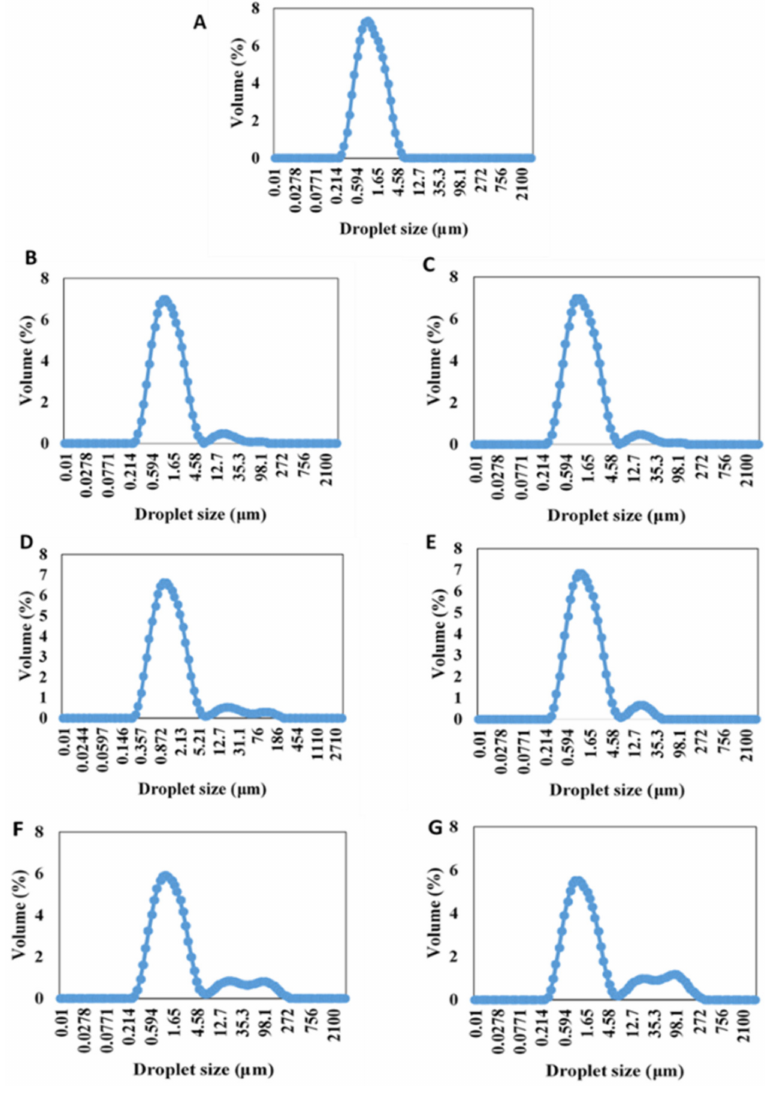
Figure 1. Particle size distributions of 10% ( w / w ) O/W emulsions containing β -carotene without nanocellulose ( A ) and with nanocellulose, including 0.05% ( w / w ) NCC ( B ), 0.10% ( w / w ) NCC ( C ), 0.20% ( w / w ) NCC ( D ), 0.05% ( w / w ) NFC ( E ), 0.10% ( w / w ) NFC ( F ), and 0.20% ( w / w ) NFC ( G